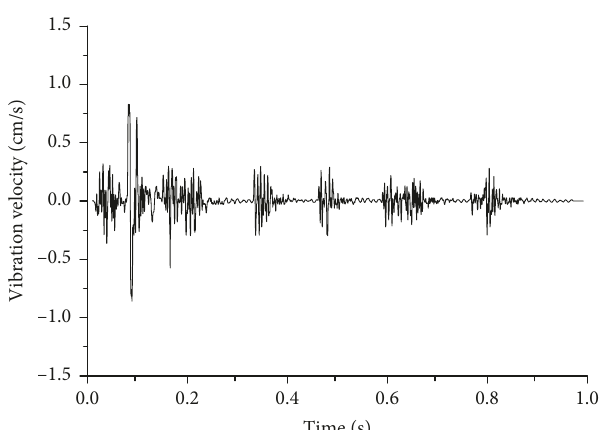
Figure 12: Vertical vibration waveform of the upper step at C-3.